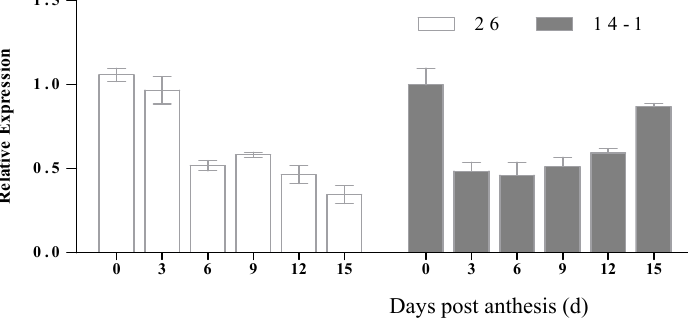
Figure 4. Expression levels of the CsHPL gene in No. 26 (an inbred line of Northern China) and CsHPL gene in No. 14-1 (an inbred line of Southern China) during fruit development post-anthesis. Expression levels of fruit CsHPL genes were analyzed by using quantitative real-time PCR during cucumber fruit development after anthesis. Y axis represents relative expression values. Data represent the means ± SD of three biological replicates (fruits from three plants were taken as a biological replicate). The expression of the genes was normalized with reference to the expression of the actin gene.